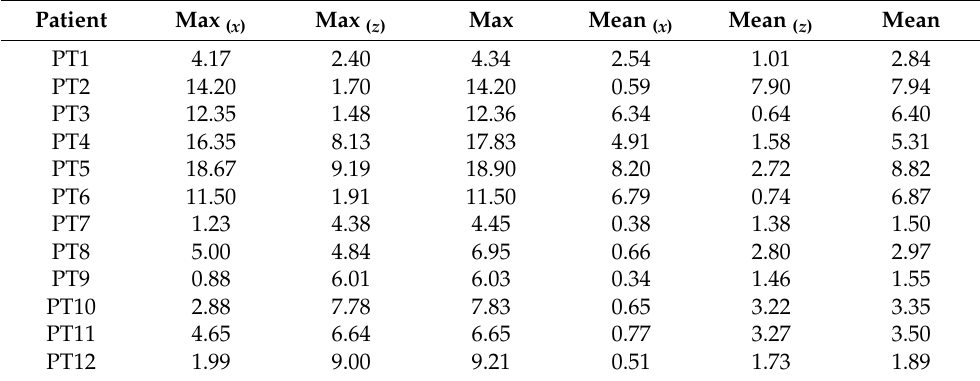
Table 1. Maximal and mean deviations of the results taken as total value and decompositions on the x - and z -axes [mm].